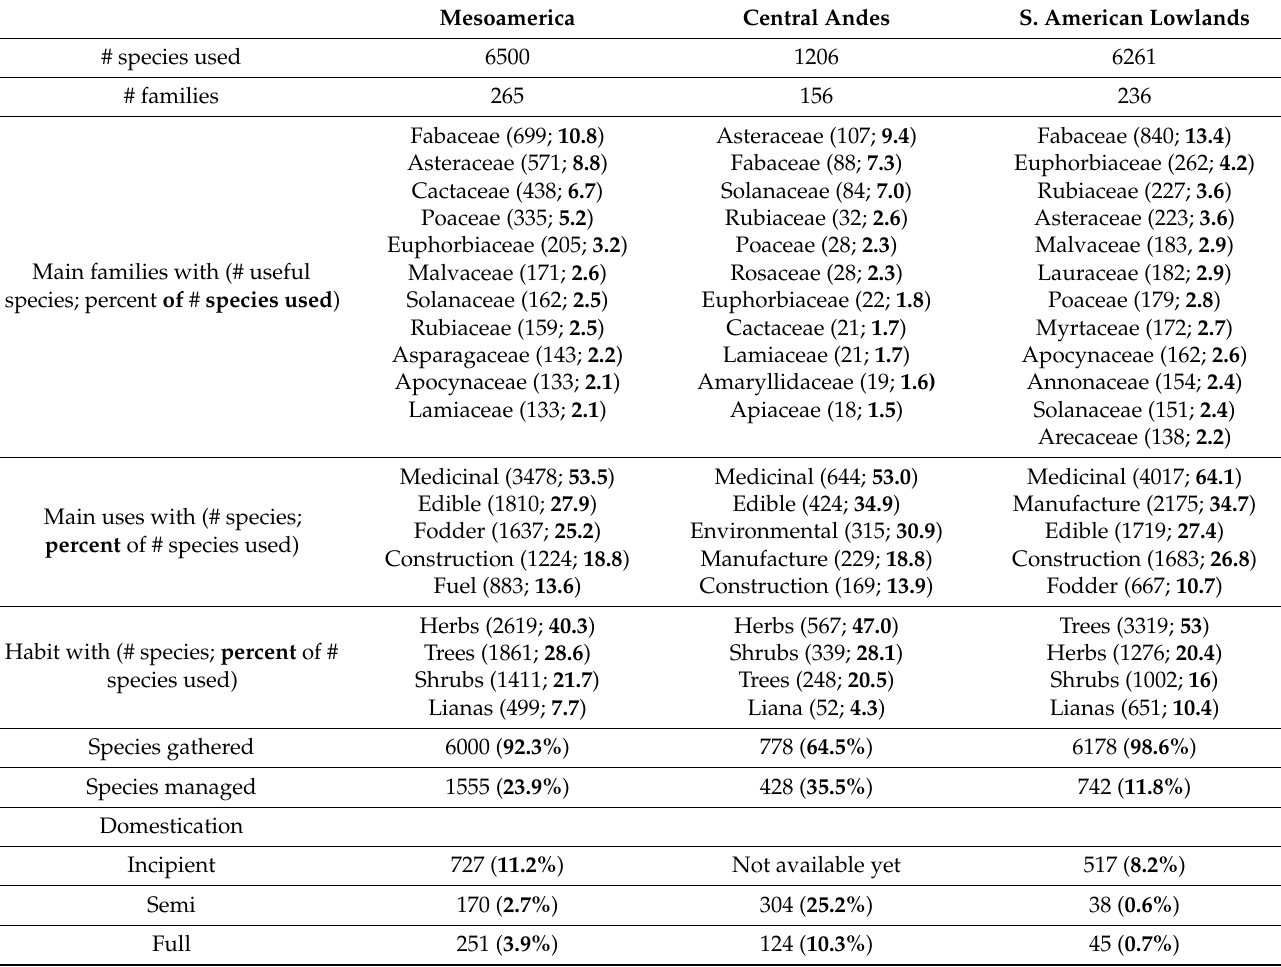
Table 1. General panorama of the native plant species used and managed as resources in the Neotropics. Notice that total numbers (#) and percentages of forms of use and management are higher than 100%, since a species may have more than one use and form of management. Because useful species are widely distributed across the Neotropics, some may overlap among regions (Mesoamerica, Central Andes and South American lowlands). Access to lists can be requested from the coordinators of each data